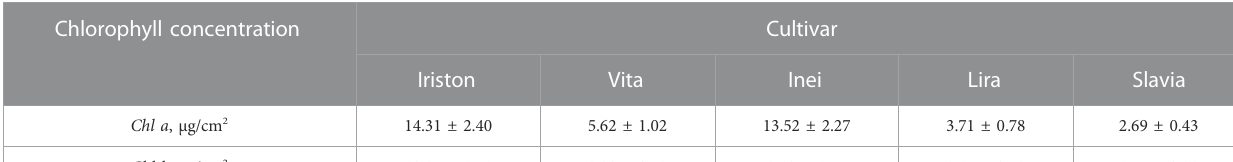
TABLE 2 Reference SS values obtained from three (spectrophotometric) measurements.